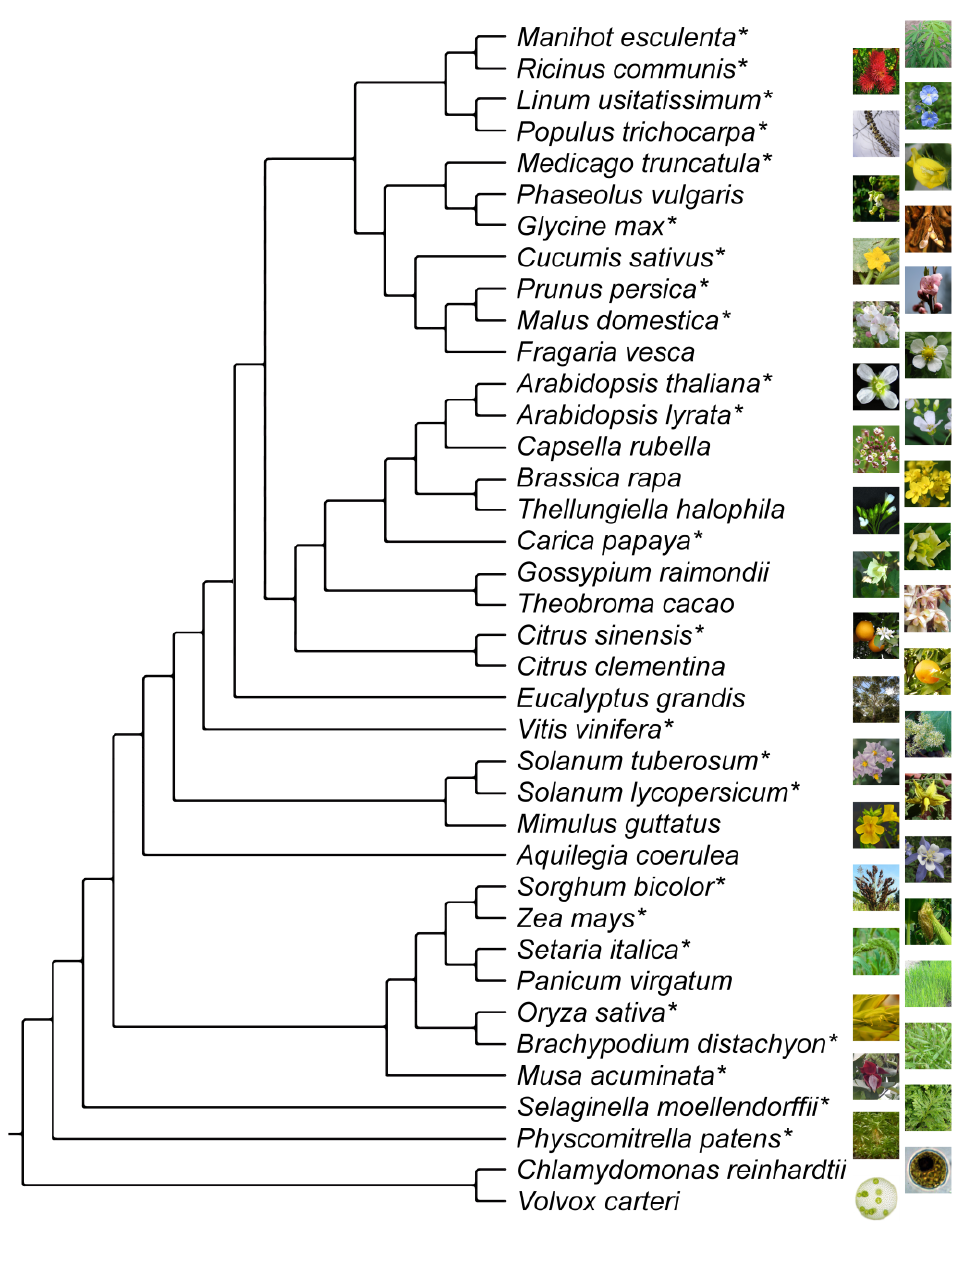
Figure 1. Phylogeny of land plants for which whole-genome information is now available. Chlamydomonas reinhardtii and Volvox carteri are green algae and used as representatives of the outgroup. Species for which MADS-box genes are studied here are indicated by an asterisk. The topology of the tree was taken from